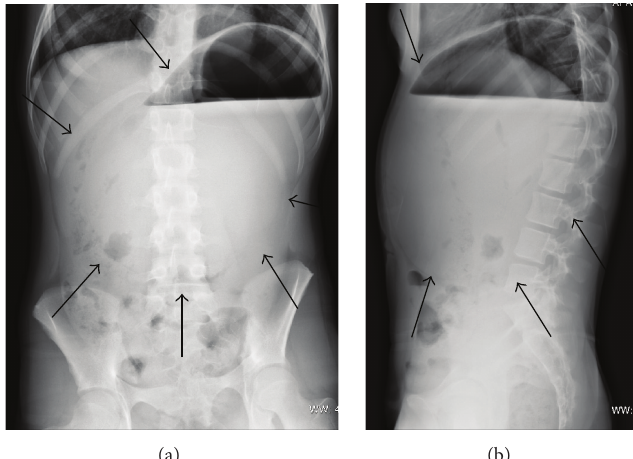
Figure 1: Anteroposterior (a) and lateral (b) projections of the abdominal X-ray. The distended stomach (black arrows) occupies epigastrium and mesogastrium; air-fluid level is present in the gastric fundus.